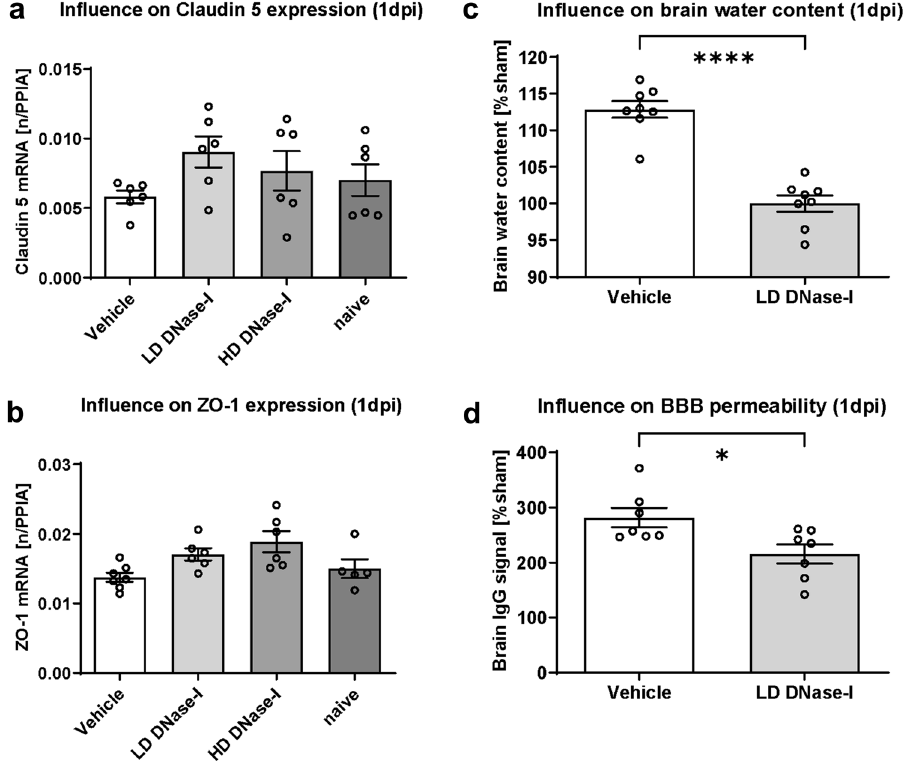
Figure 2. Regulation of cerebral edema severity and blood–brain barrier (BBB) integrity post-CCI. ( a b ) Upregulation of the mRNA levels of tight junction proteins Claudin-5 ( a ) and ZO-1 ( b ) following DNase-I treatment (n = 10 mice/group), consistent with BBB preservation. ( c ) Brain water 24 h post-CCI (1 dpi) was significantly lower in the LD DNase-I (2 mg/kg) group (n = 8 mice/group). Brain water content and IgG levels were determined in a separate set of animals with the best effective dosage in terms of lesion volume (2A): ( d ) BBB integrity 1 dpi as evidenced by immunoglobulin G (IgG) extravasation. Blots were revealed by near infrared laser scanning, quantification was performed with ImageJ. Levels were significantly lower in DNase-I-treated animals (n = 8 mice/group). A significance level p < 0.05 is marked with *, p < 0.01 with **, and p < 0.001 with ***. All data are presented as mean ± SEM; p values are adjusted for multiple comparisons by Sidak